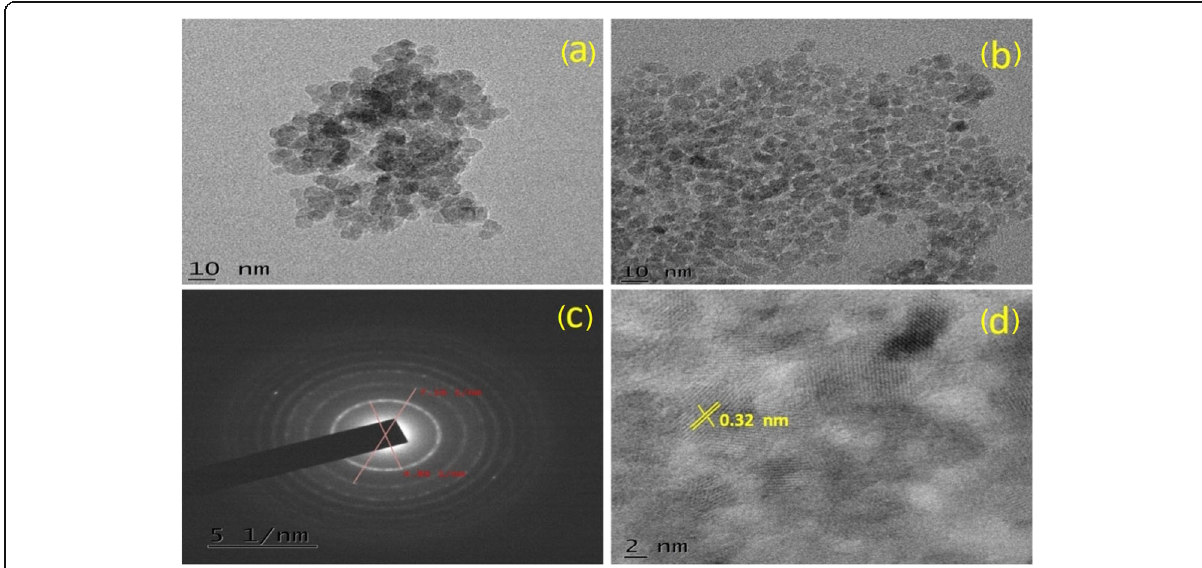
Fig. 6 TEM image of a MMT5, b MMT5-GS2, c Selected area electron diffraction (SEAD) and d HRTEM image of MMT5-GS2